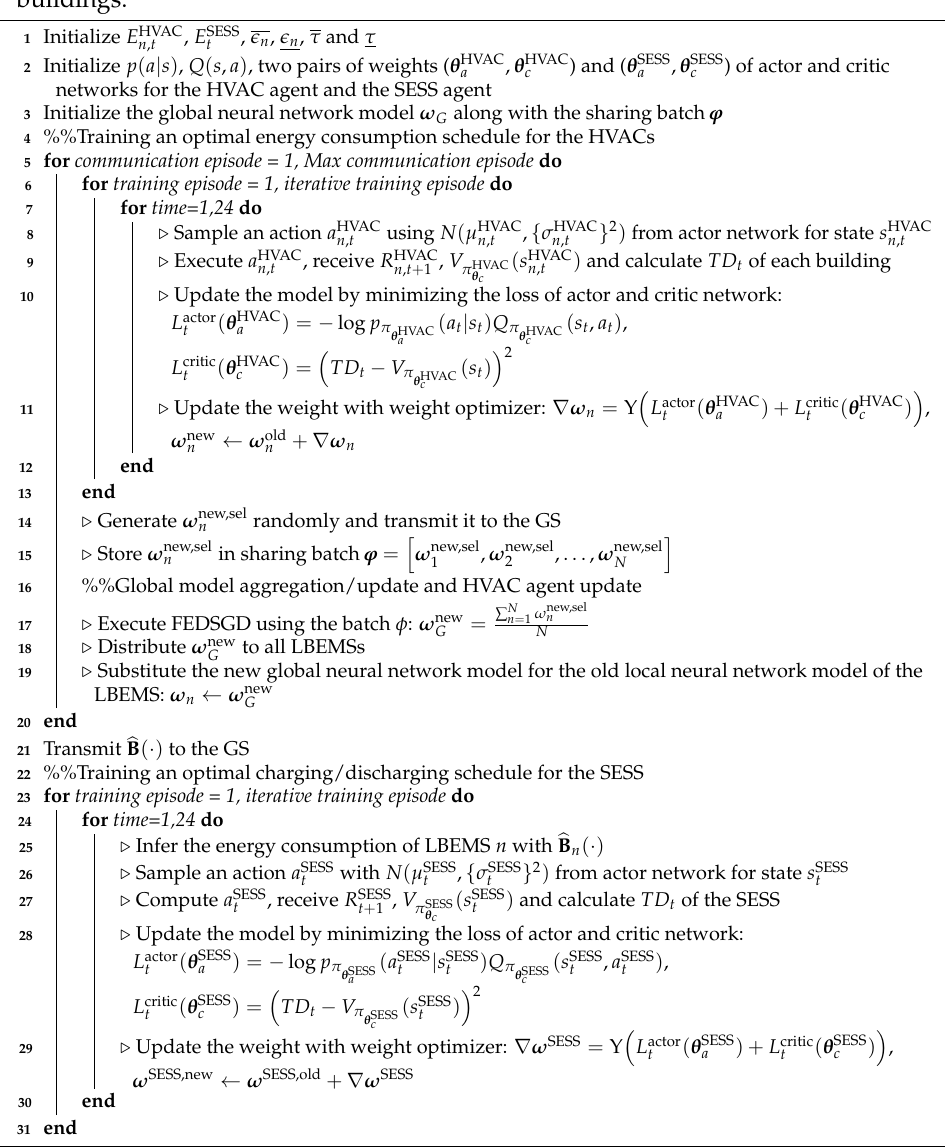
Algorithm 1: FRL-based energy management of a SESS with multiple